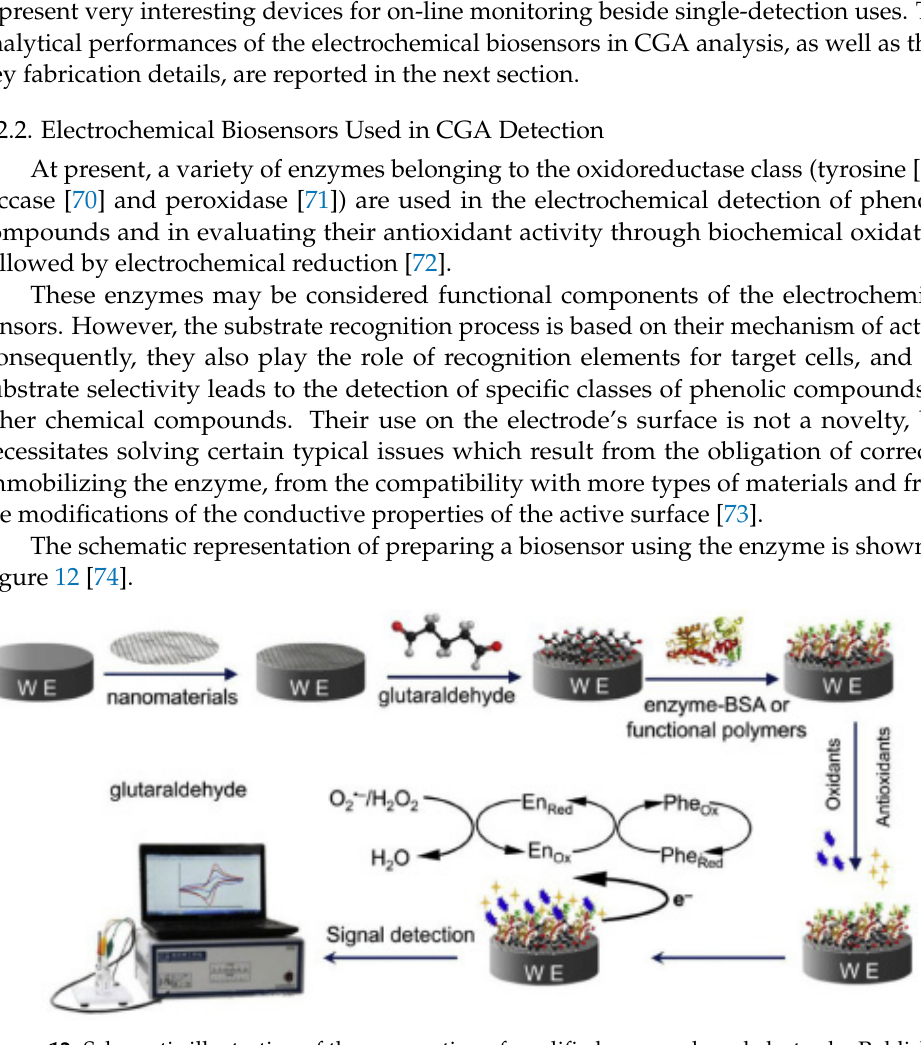
Figure 12. Schematic illustration of the preparation of modified enzyme-based electrode. Published from [74] with the permission of the publisher.